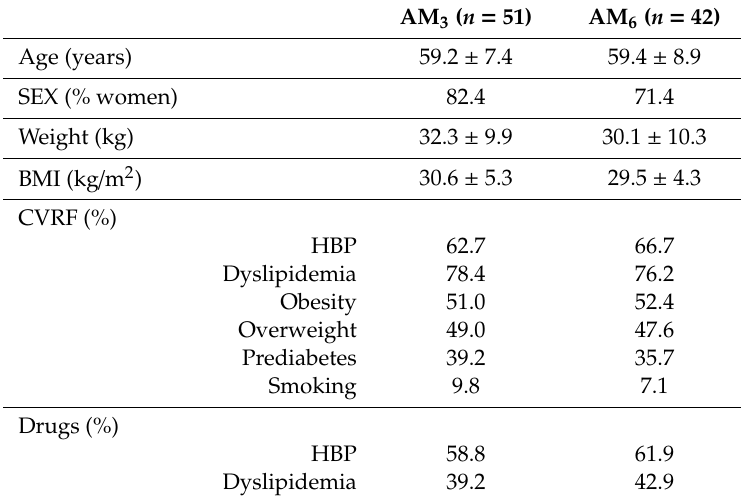
Figure 2. Flow diagram of the progress of the prospective observational cohort study. Table 3. Participants characteristics and